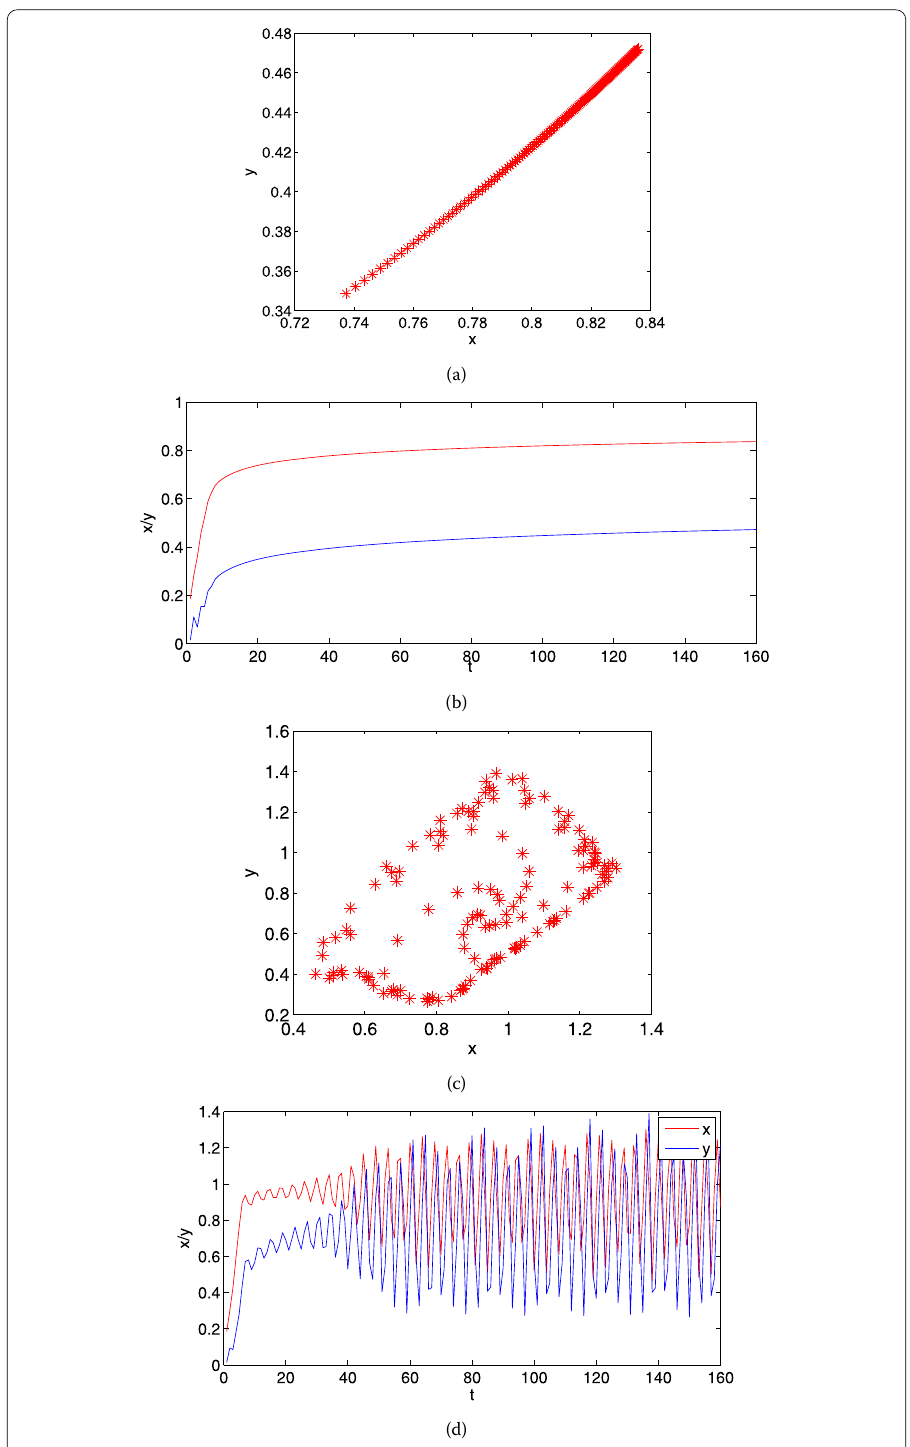
Figure 2 Phase portraits and their corresponding chaotic solutions. Phase portraits and solutions of system (11) with a = 1, h = 0.95, and different values of α . ( a , b ) α = 1, ( c , d ) α = 0.3, ( e , f ) α = 0.5, ( g , h ) α = 0.75, ( i , j ) α = 0.81, ( k , l ) α =